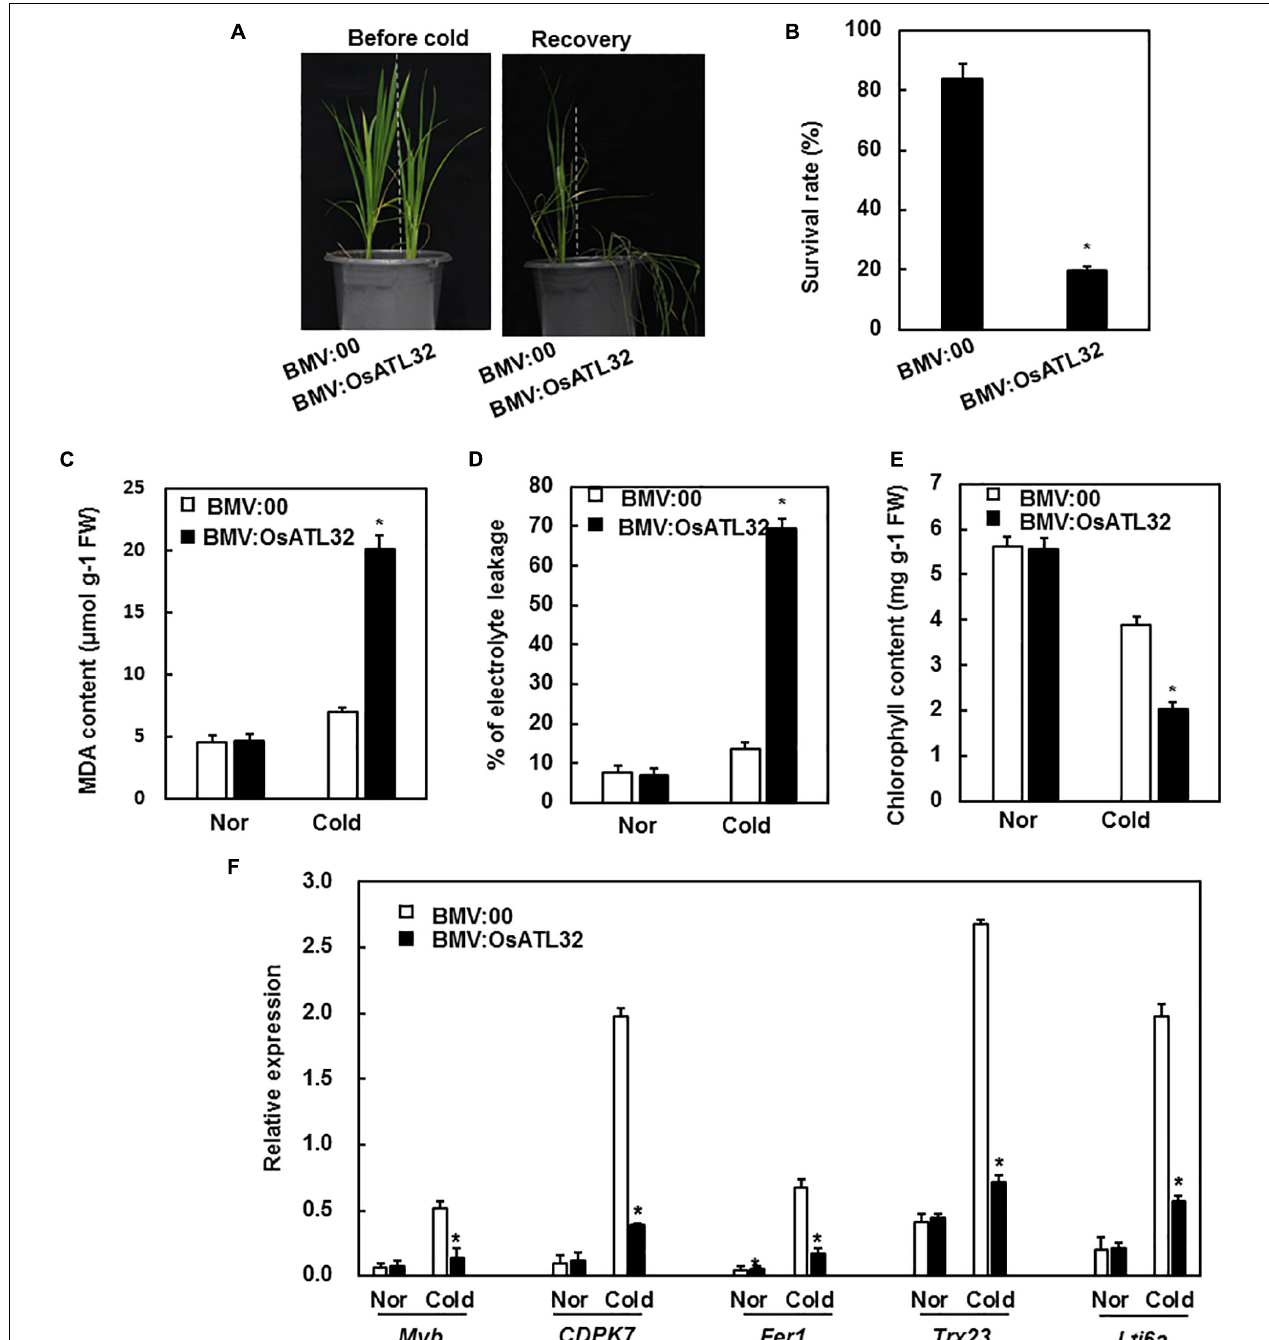
FIGURE 6 | BMV:OsATL32-infiltrated seedlings showed decreased tolerance to cold stress when compared to the control. Four-week-old BMV:OsATL32- and BMV:00-infiltrated seedlings in the same pot were placed in a growth chamber at 4 ◦ C for 2 days, then transferred to normal growth conditions. Seven days later, the survival rate, MDA content, chlorophyll content, electrolyte leakage, and expression levels of cold-responsive genes were analyzed. (A) The phenotype of BMV: OsATL32-infiltrated plants after exposure to cold stress. (B) The survival rates were recorded. MDA content (C) , electrolyte leakage (D) , and chlorophyll content (E) were analyzed in BMV:OsATL32- and BMV:00-infiltrated seedlings with or without exposure to cold stress. (F) Expression of cold-responsive genes in BMV:OsATL32- and BMV:00-infiltrated seedlings with or without exposure to cold stress. Expression levels of cold-responsive genes were analyzed using qRT-PCR with gene-specific primers. Data presented are the means ± SD from three independent experiments, and * above the columns indicate significant differences between BMV:OsATL32- and BMV:00- infiltrated plants at p < 0.05 level.